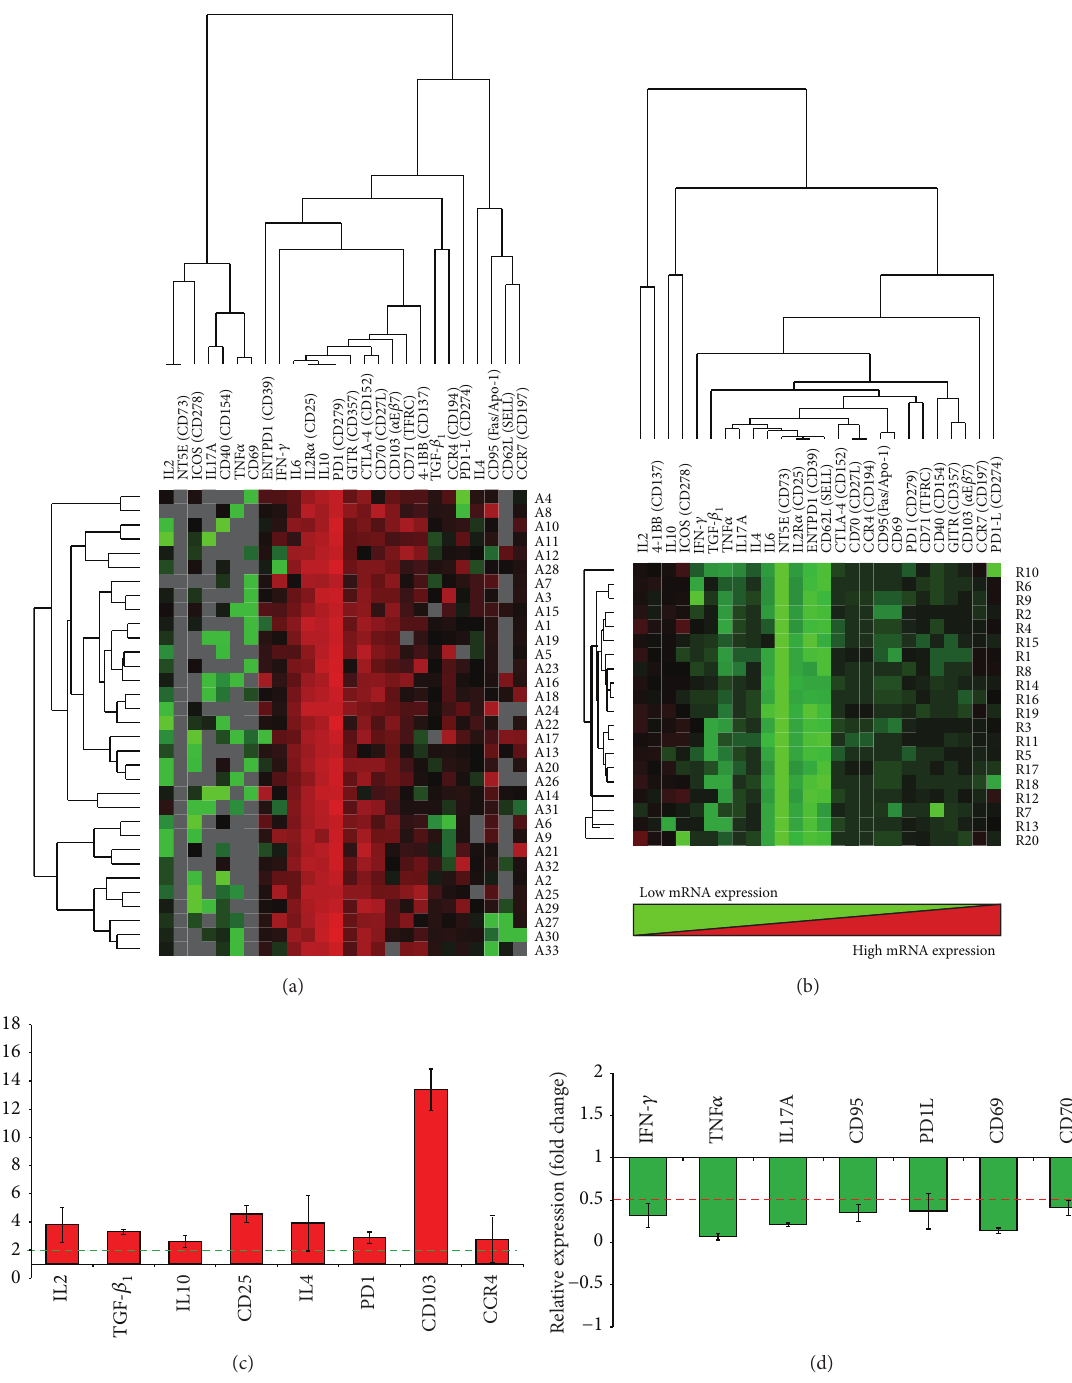
Figure 4: Gene expression profiles in hepatitis E infection by TLDA. (a) Gene expression profiles using customized TLDA panel by two- way hierarchical clustering on unstimulated PBMCs from AVH-E patients, recovered individuals after normalization with healthy controls. Each colored cell in the two hit maps represents the relative levels of expression of particular genes in a study subject. Green indicates low levels and red indicates high levels of gene expression. Values for 26 selected genes were hierarchically clustered on log transformation. The corresponding gene of each cluster is listed by a gene symbol on the top side of the images. Genes were ordered according to their cluster determined by the k -means algorithm. (a) AVH-E patients denoted as A1–A33; (b) recovered individuals denoted as R1–R20 on the right side of the images. Values increase from green to red, via black. (c-d) HEV rORF2p stimulated gene expression of in vitro cultured PBMCs of AVH-E patients. The values shown are the mean fold change of rORF2p stimulated PBMCs compared with the unstimulated PBMCs. Values are expressed as mean ± standard